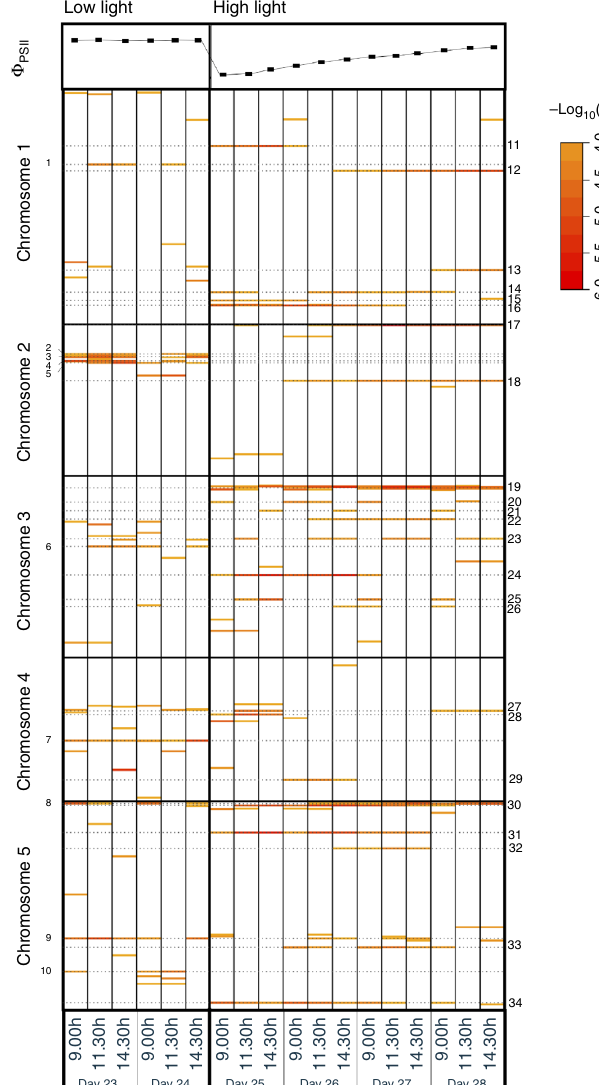
Fig. 2 Heat map of SNP – Ф PSII association strengths as identi fi ed upon GWAS. A genome-wide association study (GWAS) of Ф PSII is performed, before and after an increase in growth irradiance, based on a panel of 344 Arabidopsis accessions. Plant Ф PSII (shown for Col-0 in the left panel) is measured three times per day, two days in low light (100 µ mol m − 2 s − 1 ) and four days in high light (550 µ mol m − 2 s − 1 ), as indicated in the right panel. The fi rst measurement each day is taken 1 h after the beginning of the photoperiod. SNP – Ф PSII association strengths are reported as − log 10 ( p ) values. The fi ve Arabidopsis chromosomes are presented according to their physical size. Quantitative trait loci are numbered, 1 – 34. 1 – 10 are low-light speci fi c, 11 – 34 are high-light speci fi